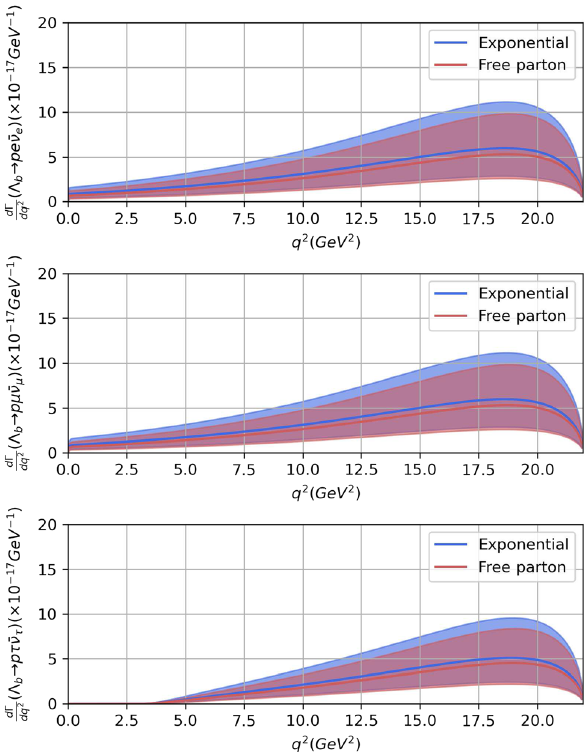
Fig. 7 q 2 dependencies of the differential widths for the (cid:2) b → p (cid:3) ¯ ν (cid:3) decays with (cid:3) = e ,ν,τ